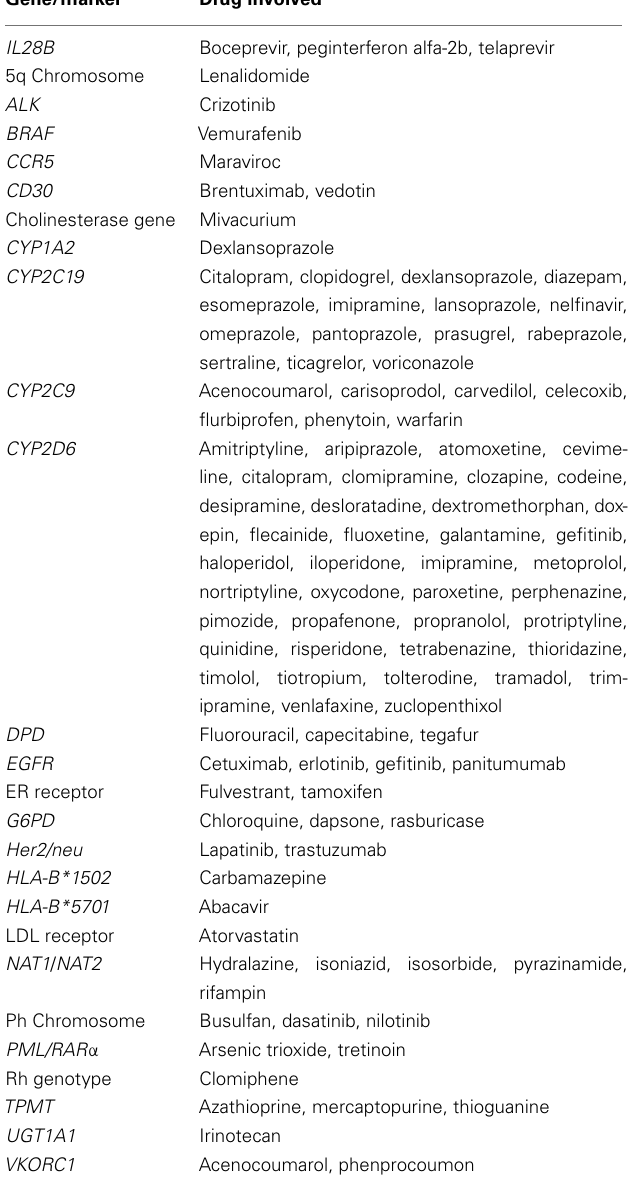
Table 2 | Examples of pharmacogenomic targets with therapeutic